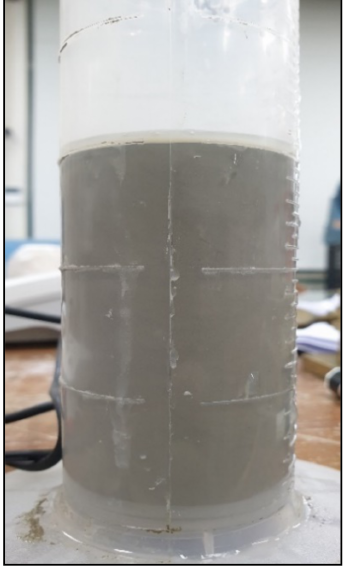
Figure 5. Method to test the bleeding of grout sample. The dispersiveness of the grout samples was checked by pouring the grout into a water-filled beaker, as depicted in Figure 6.